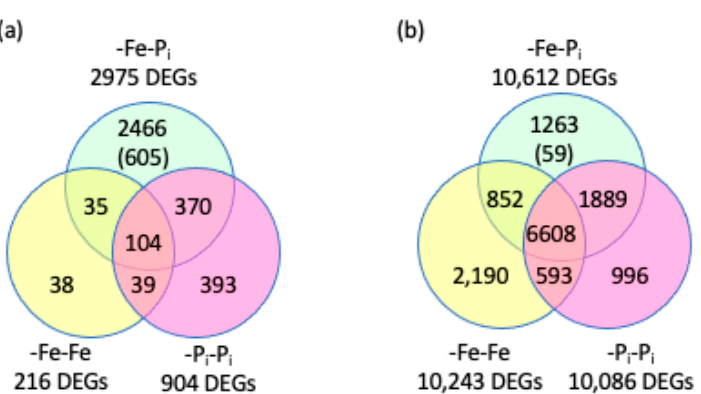
Figure 4. Differentially expressed genes (DEGs) identified in iron deficiency followed by phosphate deficiency (-Fe-P i ) stressed soybean leaves ( a ) and roots ( b ) compared to previously published results of repeated iron deficiency stress (-Fe-Fe) or repeated phosphate deficiency stress (-P i -P i ) leaves and roots [34]. Only genes within and overlapping with the -Fe-P i circle are discussed throughout the manuscript. Numbers presented in parentheses represent the number of –Fe-P i unique genes identified after altering parameters as described in Section 2.3 of the results.